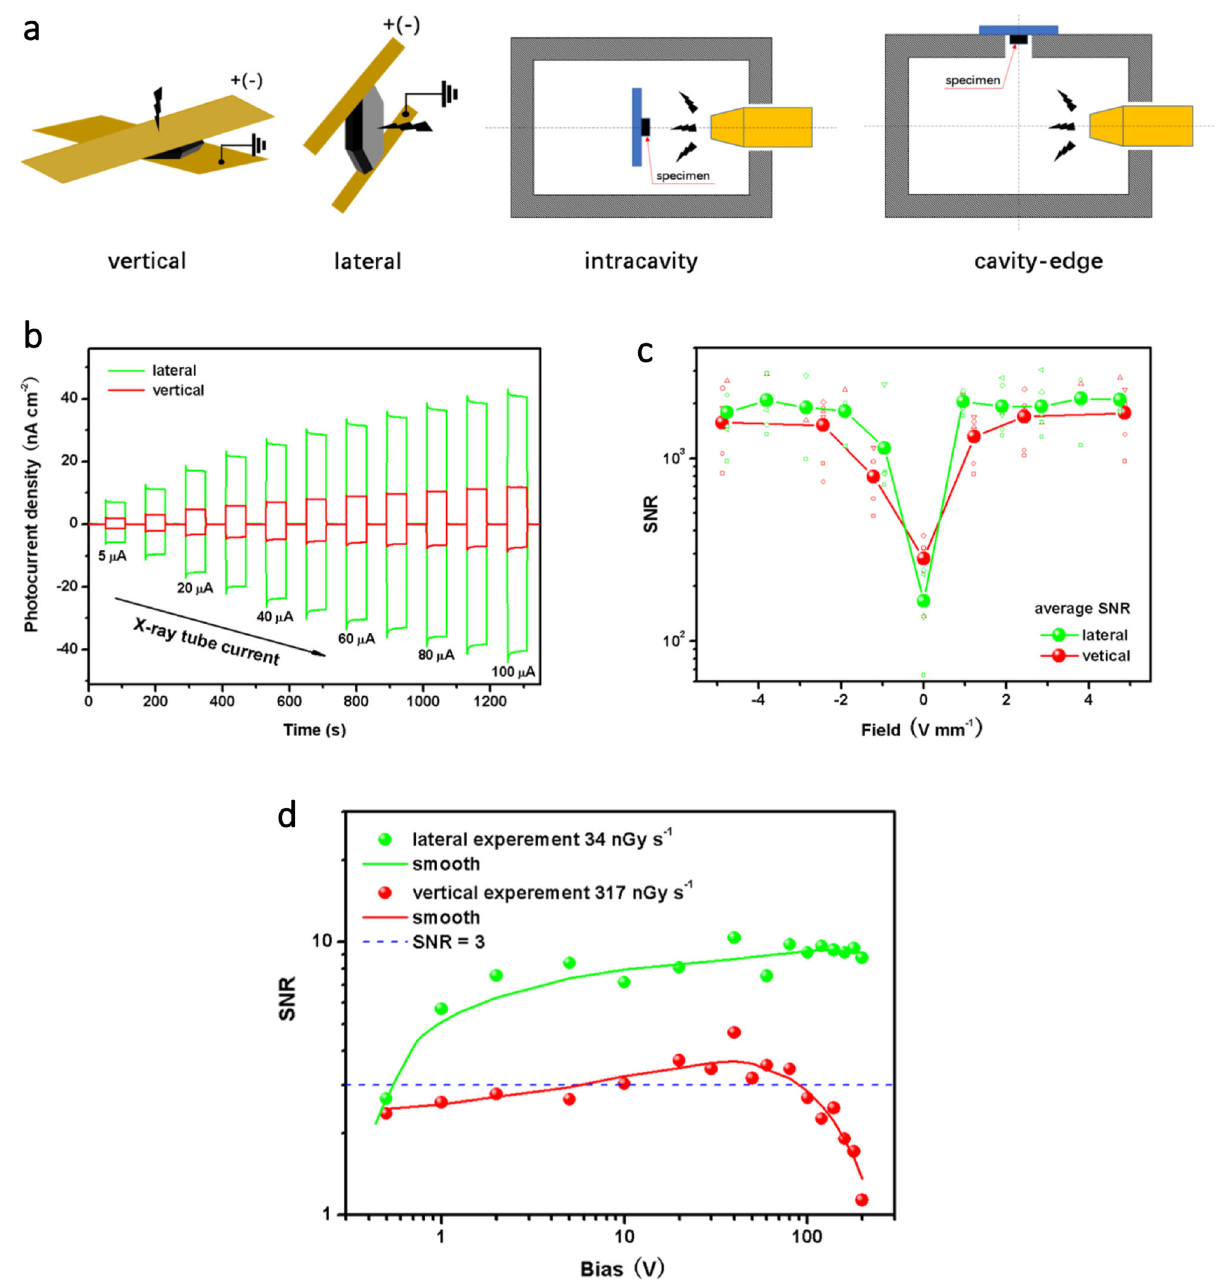
Fig. 4 | Room temperature device performance. a Illustration of X-ray detector (theCutapescoverthe wholesurfaceforfullchargecollection)andmeasurement con fi guration. b Anisotropic on/off X-ray responses of Bi x I y at different dose rates measured by intracavity con fi guration under 1Vmm − 1 bias. c Anisotropic bias- dependentSNR(averagefromvaluesunderdifferentdoserateswithanX-raytube